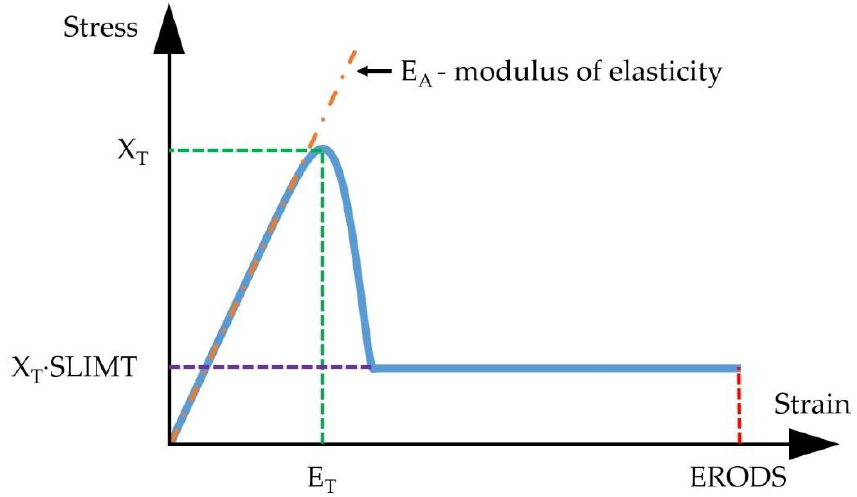
Figure 5. Typical stress—strain curve for the selected MAT58 composite material model.